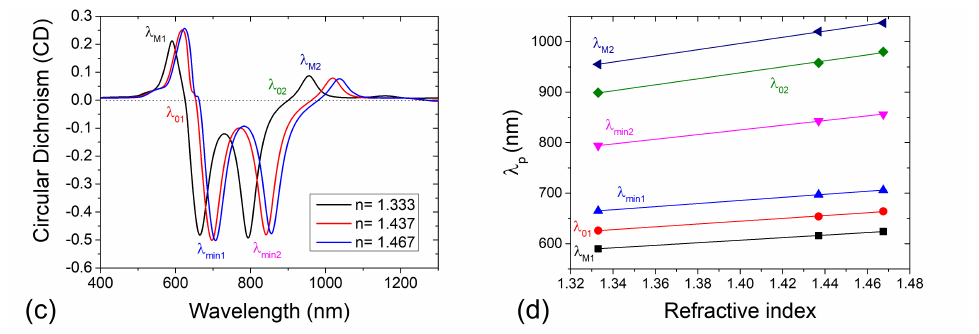
Figure 5. Absorbance and transmittance spectra of the plasmonic metasurface for ( a ) Right-Circular Polarized (RCP) and ( b ) Left-Circular Polarized (LCP) light. ( c ) CD spectra calculated in a 1,2,3- Propantriol–water solution at different molar concentrations ranging from 0% (corresponding to water (n = 1.333)) to 82% 1,2,3-Propantriol in water (n = 1.467). ( d ) Linear fit of the peak wavelength plotted versus the refractive index of the